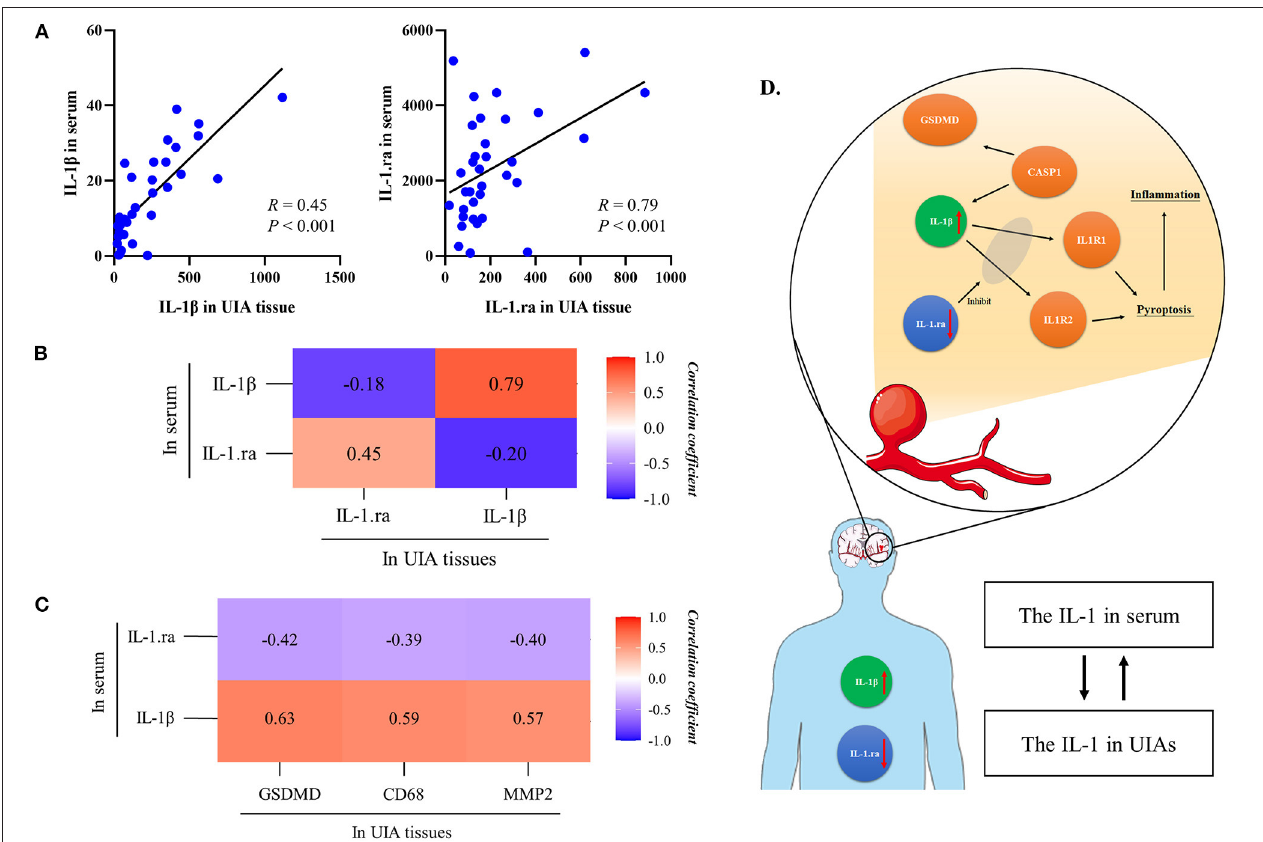
FIGURE 4 | The relationship between inflammatory factors in tissue samples and serum cytokines. (A) The relationship of IL-1 β and IL-1.ra between serum and UIA tissues. (B) The heatmap shows the correlation of IL-1 β and IL-1.ra between serum and UIA tissues. (C) The heatmap presents the correlation of serum IL-1 β /IL-1.ra and CD68, MMP2 in UIA tissues. (D) There may be a correlation between systematic proinflammatory cytokines and proinflammatory factors in UIA tissues. The IL-1 β can activate the IL-1 receptor, and induce pyroptosis and subsequent inflammation. IL-1.ra can block the combination of IL-1 β and IL-1 receptors. This biological process may be the mechanism of AWE, which could result in a massive inflammation infiltration. Therefore, we assumed that factors correlated with pyroptosis, e.g., IL-1.ra/beta ratio, may be a potential biomarker to predict aneurysm rupture or growth. UIA, unruptured intracranial aneurysm; GSDMD, gasdermin D; IL-1 β , interleukin 1 β ; IL-1.ra, interleukin